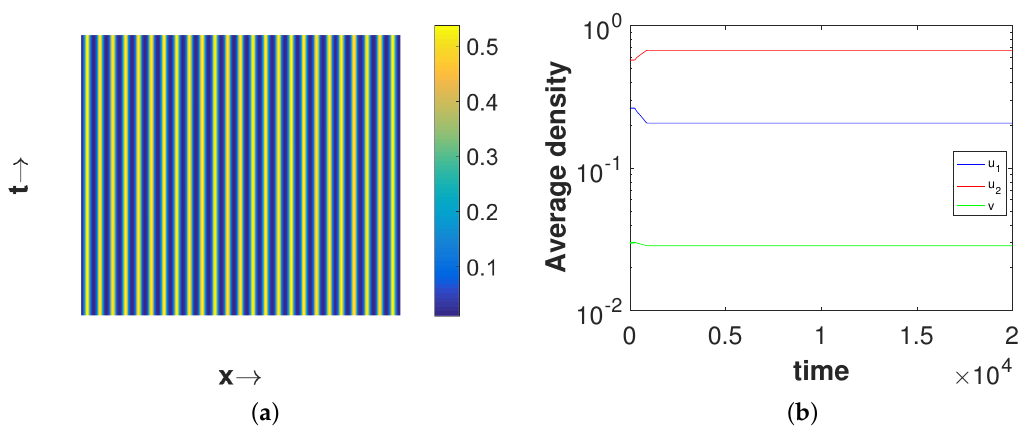
Figure 3. ( a ) Plot of stationary Turing pattern exhibited by u 1 , ( b ) time evolution of the average densities of three species. (cid:101) = 5.4 and d 3 = 9.0, other parameter values are mentioned in